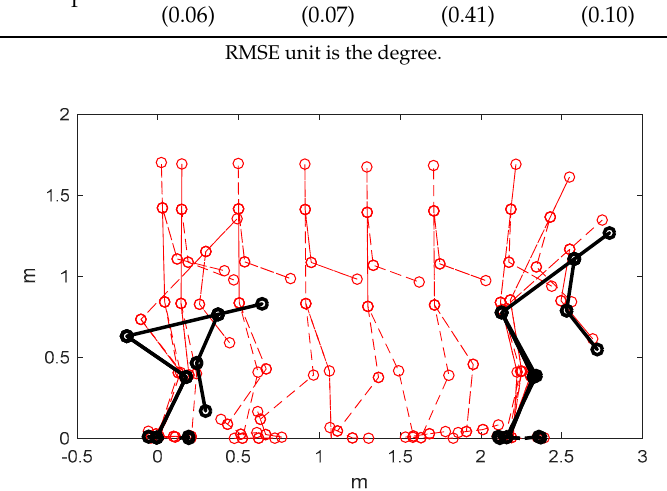
Figure 4. Predicted optimal delivery motion snapshots for a 10.16 Kg box.